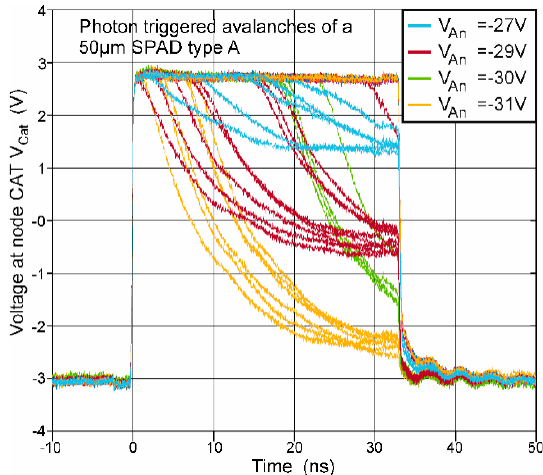
Figure 4. Transients of the cathode voltage (node CAT) of a SPAD type A with a diameter of 50 µm for different anode voltages V AN . In the illustration, transients of several active phases are overlaid. It can be seen that early avalanches quench (themselves) during the active phase, when the breakdown level is reached. Some avalanches, which occurred later in the active phase are quenched by the following reset phase. The observed breakdown level in this figure depends on the anode voltage V AN . It can be calculated with the breakdown voltage as V AN + V BD .